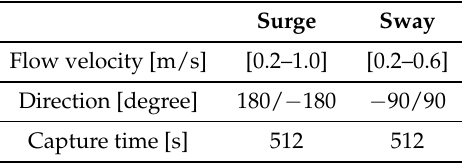
Table 1. Experimental test working conditions.